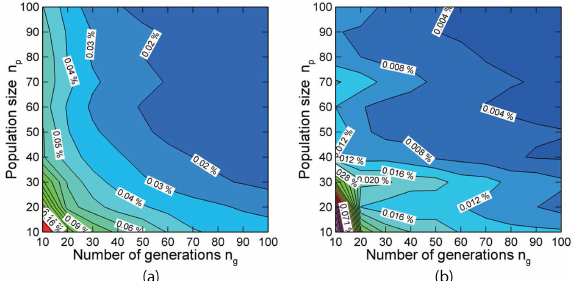
Figure 11. Variation of the mean value of the difference in flight time between the true-optimal solution ( f true = 25994 . 0 s) and the optimal solution (cid:49)f (a) , and the standard deviations of (cid:49)f ( s (cid:49)f , b ) are shown varying with the population size n p and the number of generations n g . The variation was calculated by 10 independent GA simulations from different initial populations for each combination of n p and n g : in total, 1000 independent simulations. On the (cid:49)f and q P n P n 1 s (cid:49)f : (cid:49)f = 1 (cid:49)f i , s (cid:49)f = ((cid:49)f i − (cid:49)f ) 2 , where i = 1 i = 1 n n − 1 Figure 12. Chart for finding the appropriate number of function n = 10. (cid:49)f and s (cid:49)f (in%) relative to the true-optimal solution are evaluations ( = n p × n g ), including the enlarged drawing in the early calculated as ((cid:49)f /f true ) × 100 and (s (cid:49)f /f true ) × 100, respectively. 1500 evaluations. The symbols with error bars correspond to (cid:49)f ± s (cid:49)f (in %); their definitions are given in the caption in Fig. 11. The fitted curve (power function, red line) to (cid:49)f is y = e 0 . 92 x − 0 . 59 , where x are the function evaluations and y is (cid:49)f (in %); R 2 = 0 . 89. The fitted curve to s (cid:49)f is calculated similarly: y = e 0 . 67 x − 0 . 73 , where R 2 = 0 . 71